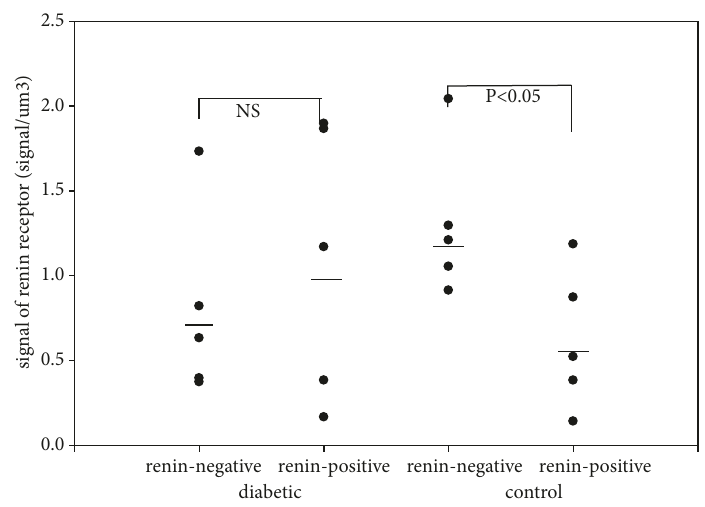
Figure 2: The number of renin receptors in the cytoplasm of afferent arteriolar SMCs. Table 3: The number of renin receptors in renin positive and renin negative SMCs in normal and diabetic rats. renin receptor in afferent arterioles cell surface (signals/ 𝜇 m 3